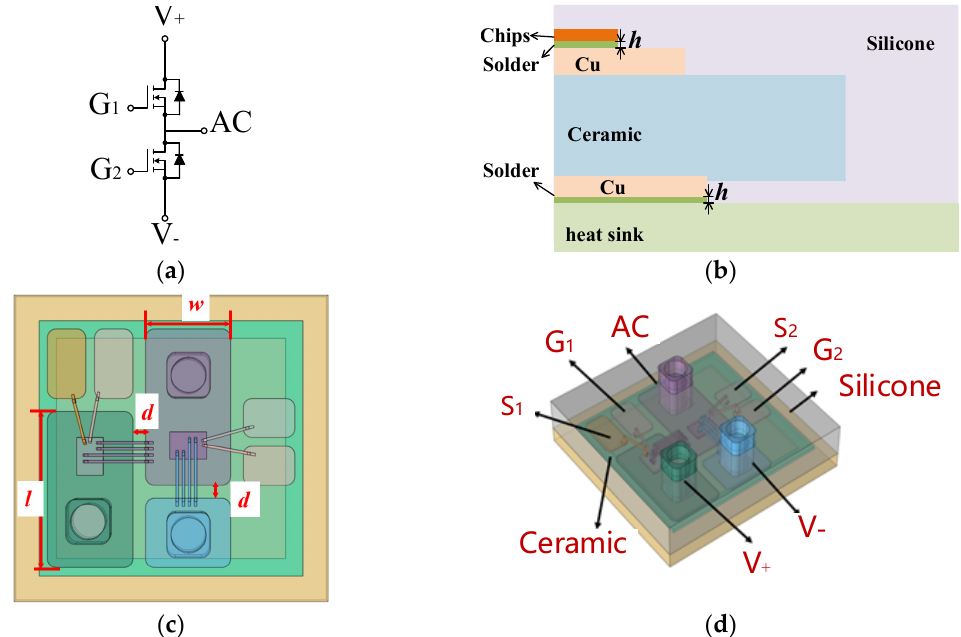
Figure 5. Packaging structure of the studied half-bridge SiC MOSFET power module: ( a ) MOSFET half-bridge circuit; ( b ) side view of the power module; ( c ) top view of the power module; ( d ) 3D structure of the power module. Table 1. Main parameters of selected materials for multi-physics simulation.